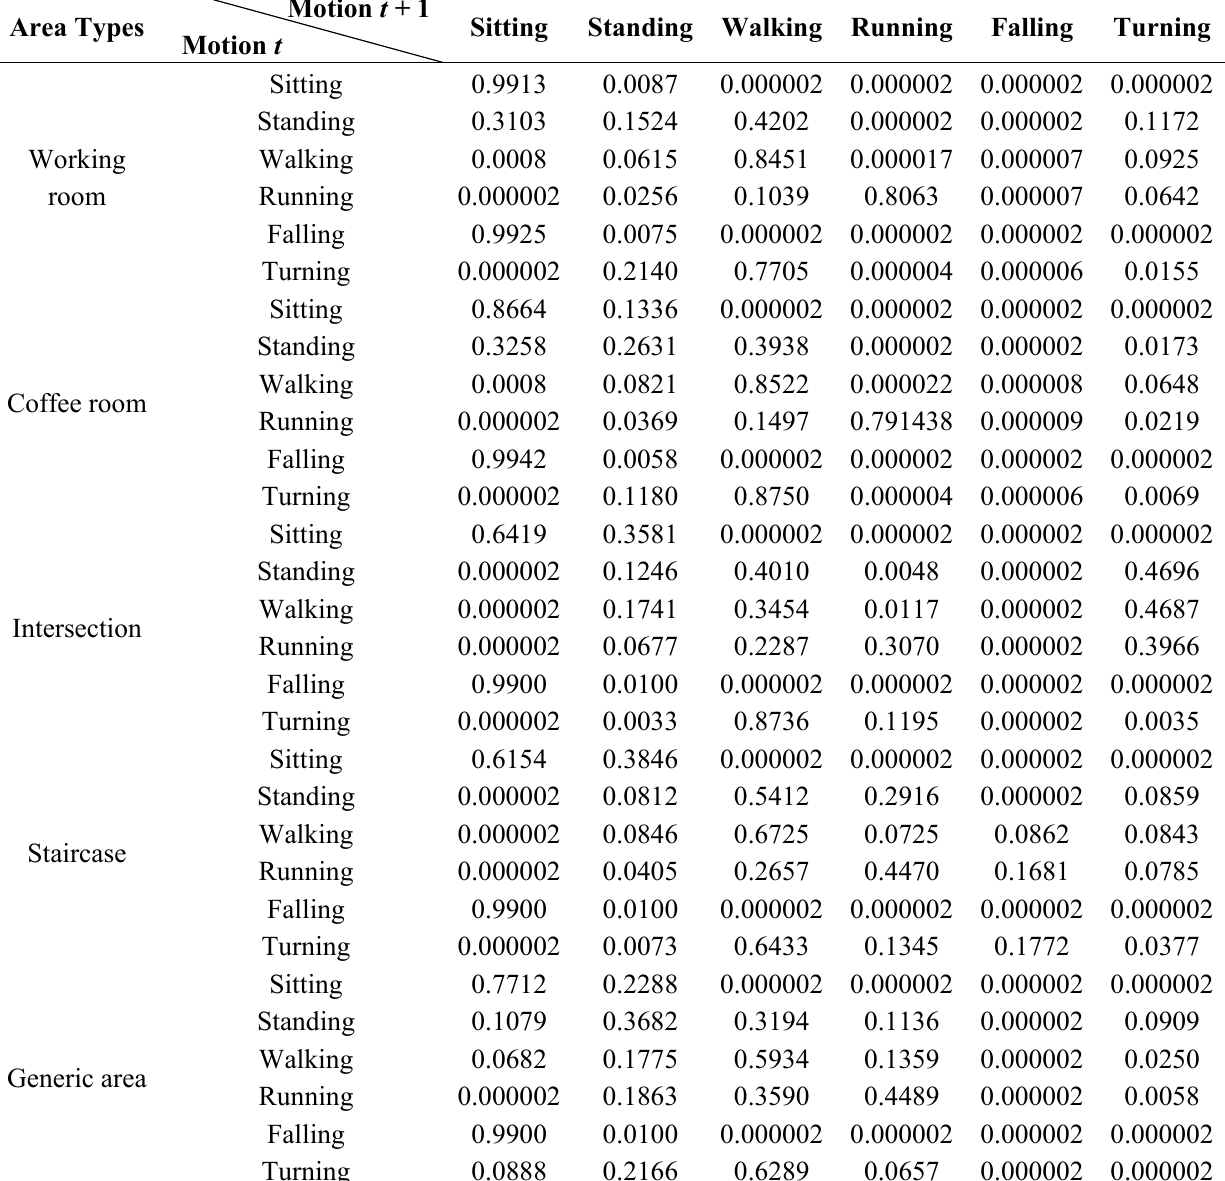
Table 2. Area type-specific motion transition probability matrix in the office environment. Area Types